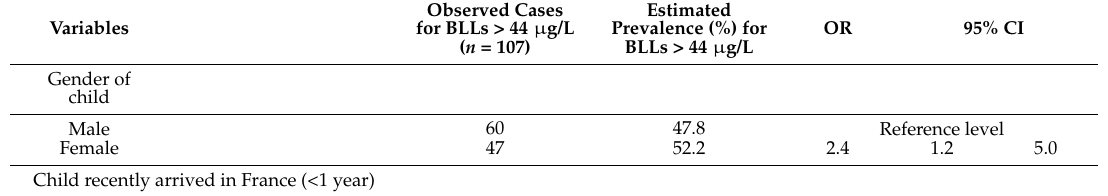
Table 4. Associations between new screening criteria and BLLs ě 44 µ g/L ( n = 2445) in children. France 2008–2009. Results from the logistic multivariable regression